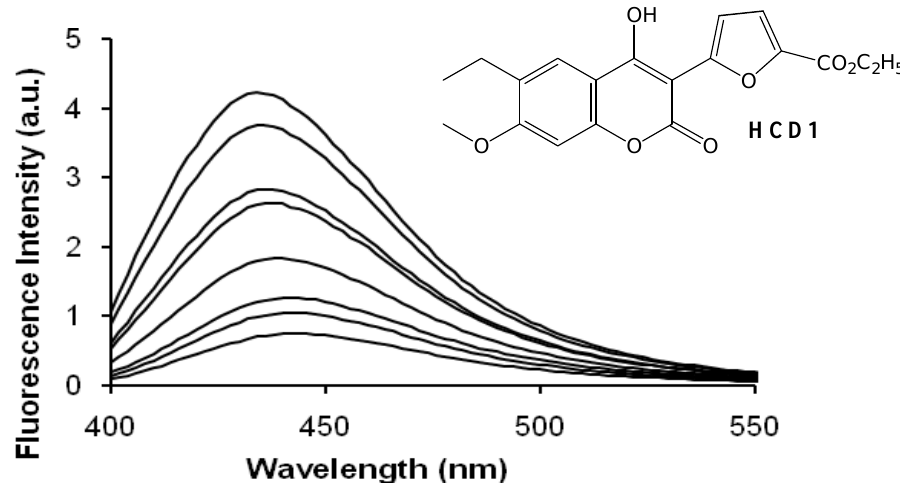
Figure 7 . Structure of HCD1 and the fluorescence spectrum of its solution (1 × 10 -5 M) in deionized water (1.3% ethanol) in the presence and absence of β -CD. From bottom to top: [ β -CD] = 0, 1 × 10 -4 , 2 × 10 -4 , 1 × 10 -3 , 2 × 10 -3 , 4 × 10 -3 , 7 × 10 -3 , and 1 × 10 -2 M. Spectra reproduced with permission from Figure 3 in Reference [41]. Copyright 2001 American Chemical